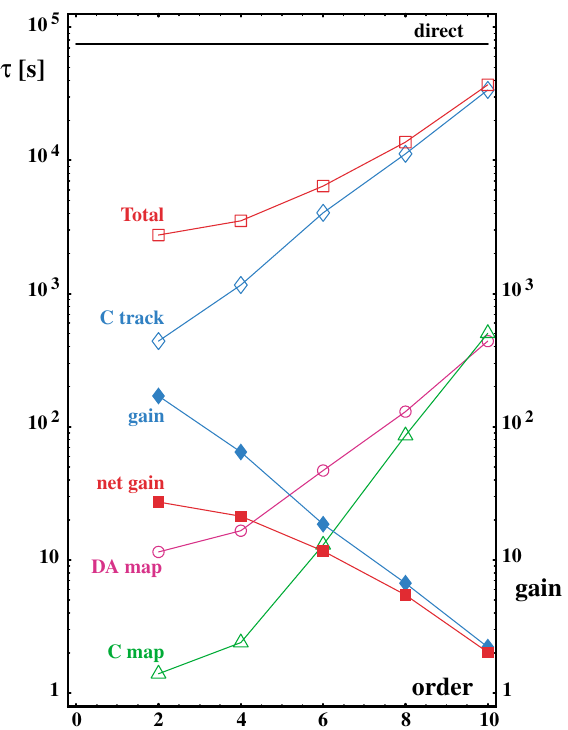
FIG. 1. (Color) This plot shows execution times (hollow sym- bols, left-hand ordinate) and speed gains (solid symbols, right- hand ordinate) versus map order for different aspects of Cremona map tracking as compared to direct tracking. Execution times are shown for creating a differential algebra map (DA map), converting it to a Cremona map (C map), doing the actual tracking (C track), and the sum of these times plus the CTRACK overhead (Total). The gains shown are just the ratios of the times required for direct tracking (shown by the horizontal line at top) and Cremona map tracking—either ‘‘C track’’ (gain), or ‘‘Total’’ (net